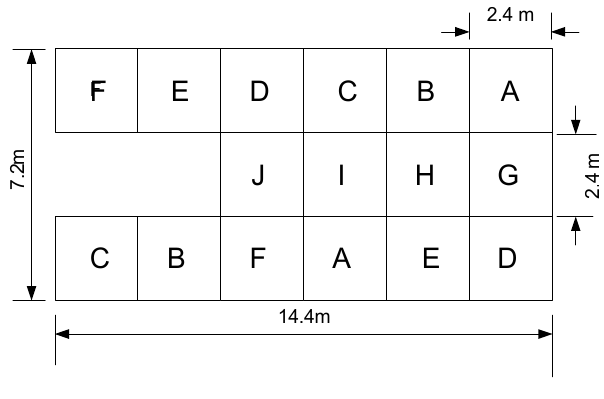
Fig. 9. Composition and layout of trial areas are Derwent